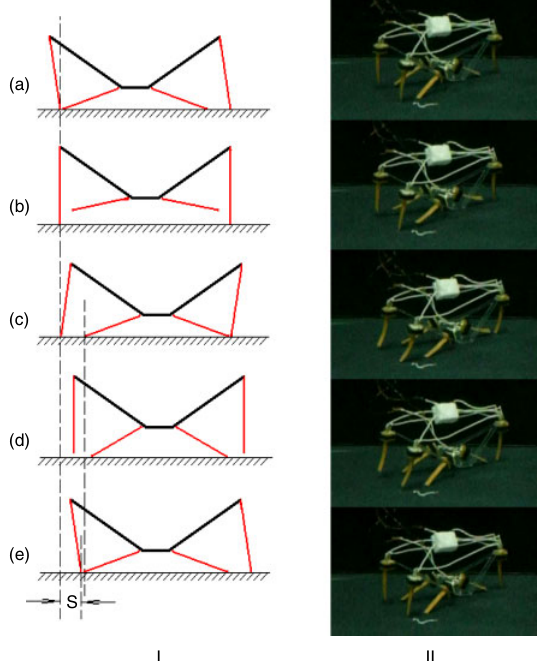
Figure 8 Walker-1 realized the two biomimetic phases.